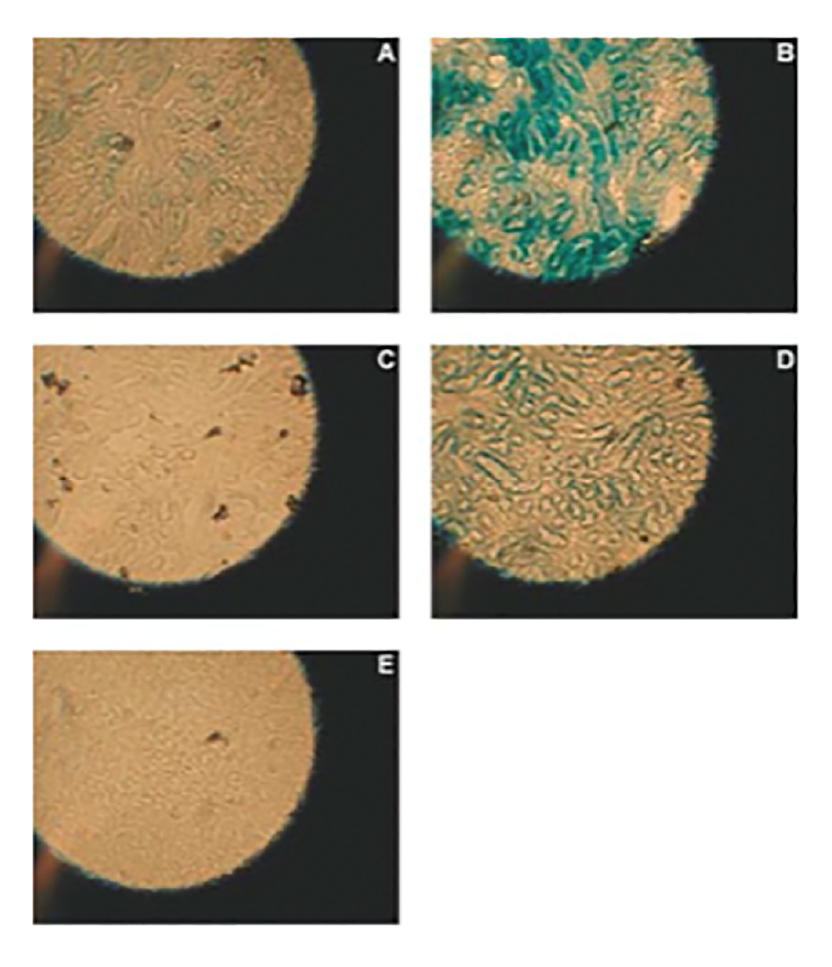
Figure 10. Gene expression in mice kidneys after systemic injection LMWC/pDNA complexes. Complexes of pUC 19 DNA with ( A ) LMWC; ( B ) 3% hydrophobically modified LMWC; ( C ) 18% hydrophobically modified LMWC and ( D ) branched PEI at N/P 5 were injected into the tail vein of the mice. The kidneys were harvested 3 days after administration. ( E ) Naked plasmid DNA injected as a control. Magnification, ×200. Reproduced from [98] with permission from